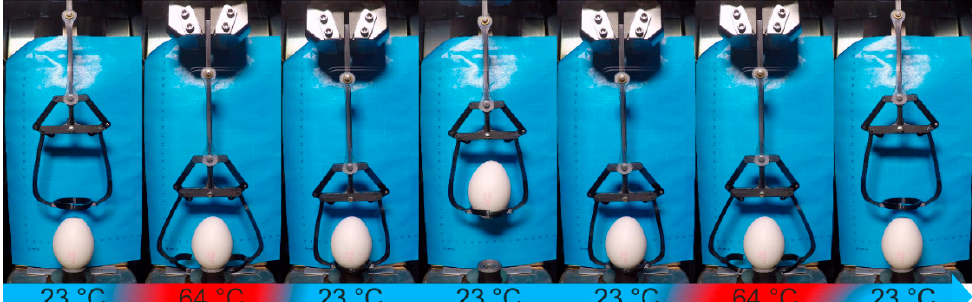
Figure 10. Gripper with PEU actuator element in operation, enabling the transport of a hen’s egg with a height of 55.5 mm, a width of 39 mm and a weight of 58 g. The lifting and lowering of the whole gripper were done manually.